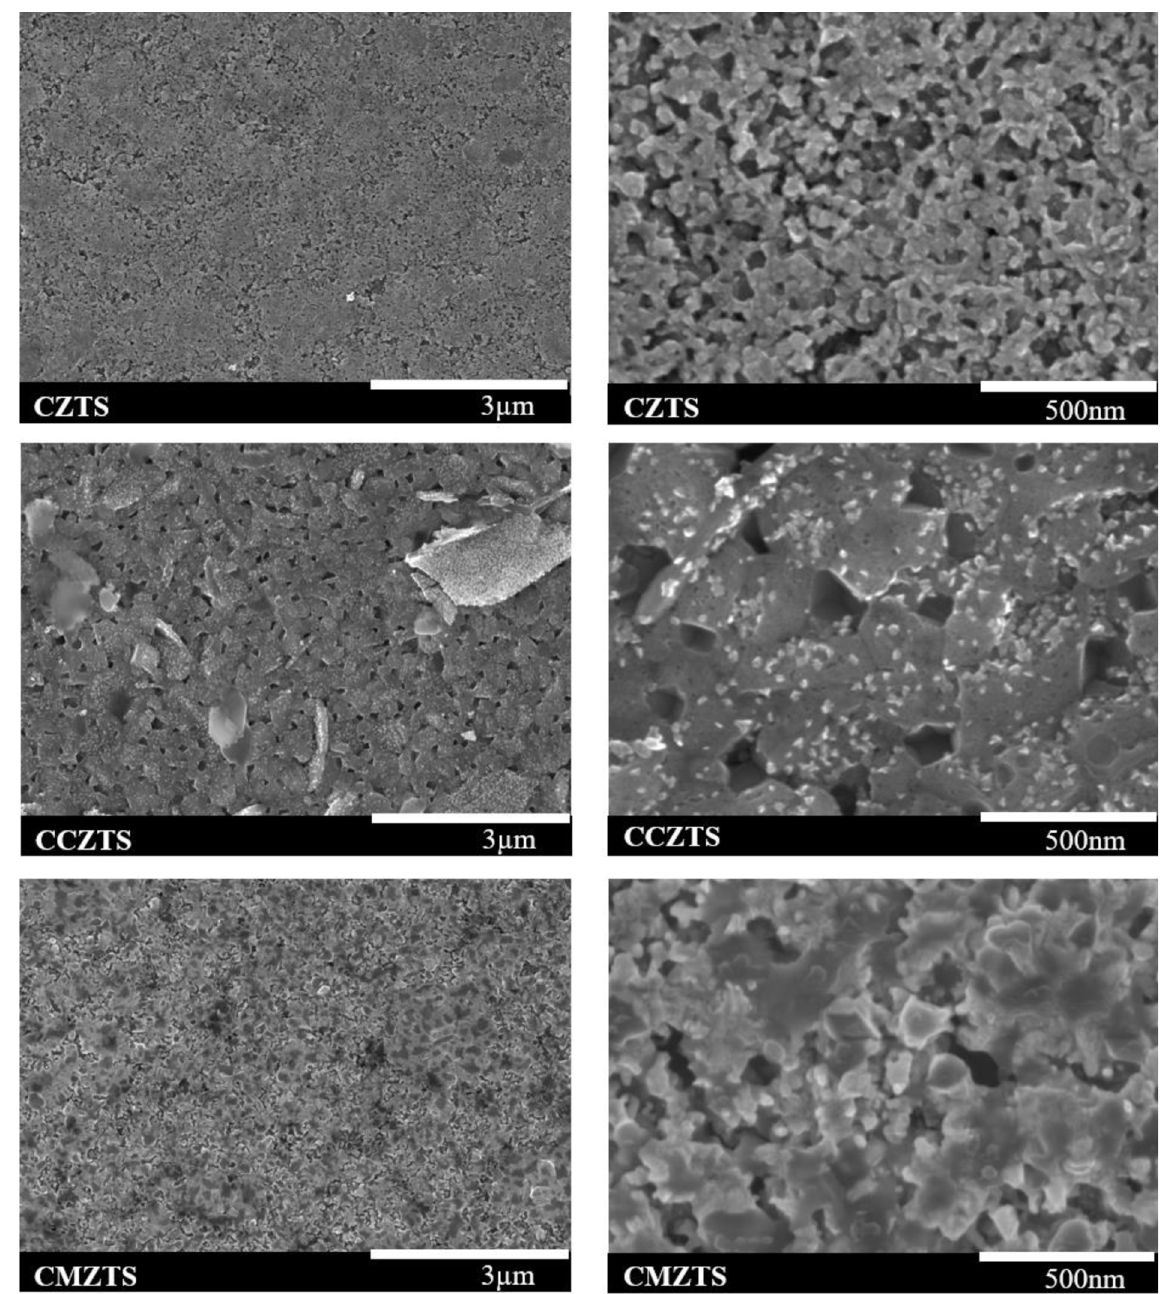
Fig. 1. SEM micrographs of CZTS, CCZTS and CMZTS